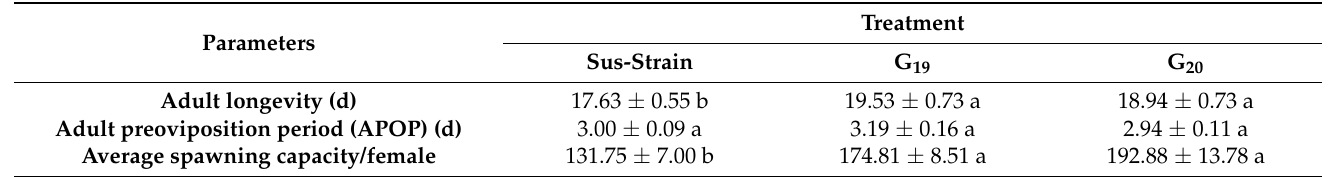
Table 1. The longevity and average spawning capacity of S. furcifera Sus-strain and Tri-strain female adult.